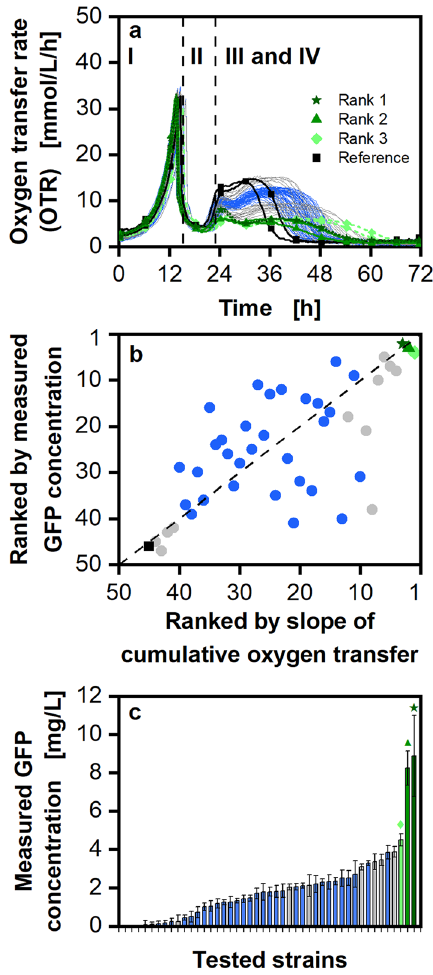
Figure 6. Cultivation of a larger clone library (45 strains) of GFP secreting P. pastoris Mut S strains in a 96-square well plate. ( a ) The OTR is depicted for a cultivation with 10 g/L glycerol and 2% (v/v) of methanol, added at the beginning of the cultivation, to obtain auto-induction conditions. For clarity, only every 20th data point is displayed. Cells were cultured at 30 °C in mineral Syn6 medium with 200 mM MES buffer (pH = 6.0). Cultivation conditions: 96-square well plate, 0.6 mL filling volume per well, 350 rpm shaking frequency. 50 mm shaking diameter, initial optical density (OD 600nm ): 0.8. Each cultivation was performed in duplicates (N = 2) and both data sets are displayed. ( b ) The different strains were ranked by the GFP concentration measured at the end of the cultivation (y-axis). The highest GFP fluorescence results in rank 1 (best) and gradually decreases to 45 according to the obtained GFP value. On the x-axis, the slope of the cumulative oxygen transfer (see Supplementary Table 3) was used as ranking criterion. Here, the lowest slope is ranked as 1 (best). If the data points lie on the angular bisector, the ranking result is considered identical for both methods. ( c ) The end point measurements of GFP fluorescence is depicted as a bar graph for the individual strains (measured in four replicates, N = 4). In order to highlight strains of special interest, the same color scheme is used in all three panels to refer to the same strains. The three best performing strains are shown in green and are also represented by a star, triangle, and a rhombus symbol. The worst producer is displayed by a black square symbol. The strains depicted in blue show a very similar OTR course and, therefore, the individual ranks are not clearly assignable. Data displayed in grey shows clearly identifiable differences in the OTR